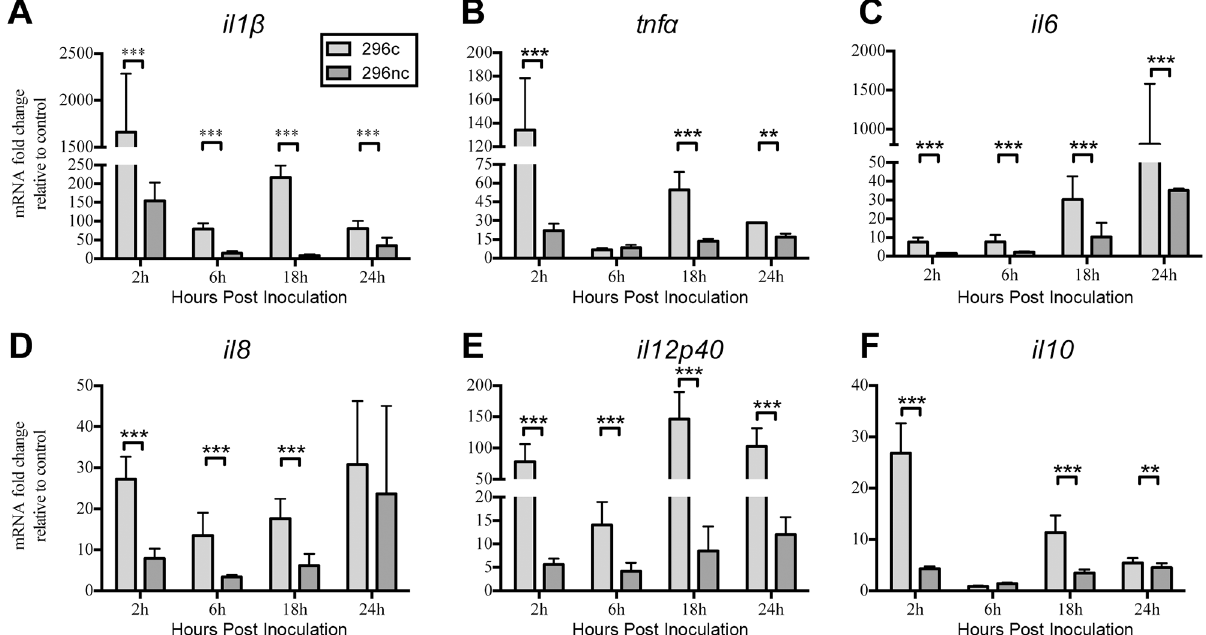
Fig 1. Expression of proinflammatory cytokine gene transcription in MDM Φ s inoculated with cytopathic or non-cytopathic BVDV2 strains. MDM Φ s were differentiated in 96 well plates for 7 days and inoculated with BVDV2 strains in duplicate at an MOI of 1 with RNA harvested at 2, 6, 18, and 24 h after inoculation. Cytokine mRNA was analyzed by qPCR using ribosomal protein s9 (RPS9) as an endogenous control with fold change expressed relative to uninfected control MDM Φ s harvested at the corresponding time points. il1 β (A), tnf α (B), il6 (C), il8 (D), il12p40 (E), il10 (F) were measured using primer sets specific for bovine genes using SYRB Green chemistry. Bars represent the mean value ± SEM from four different experiments with 9 total donor cattle. *** P < 0.001; ** P < 0.005.